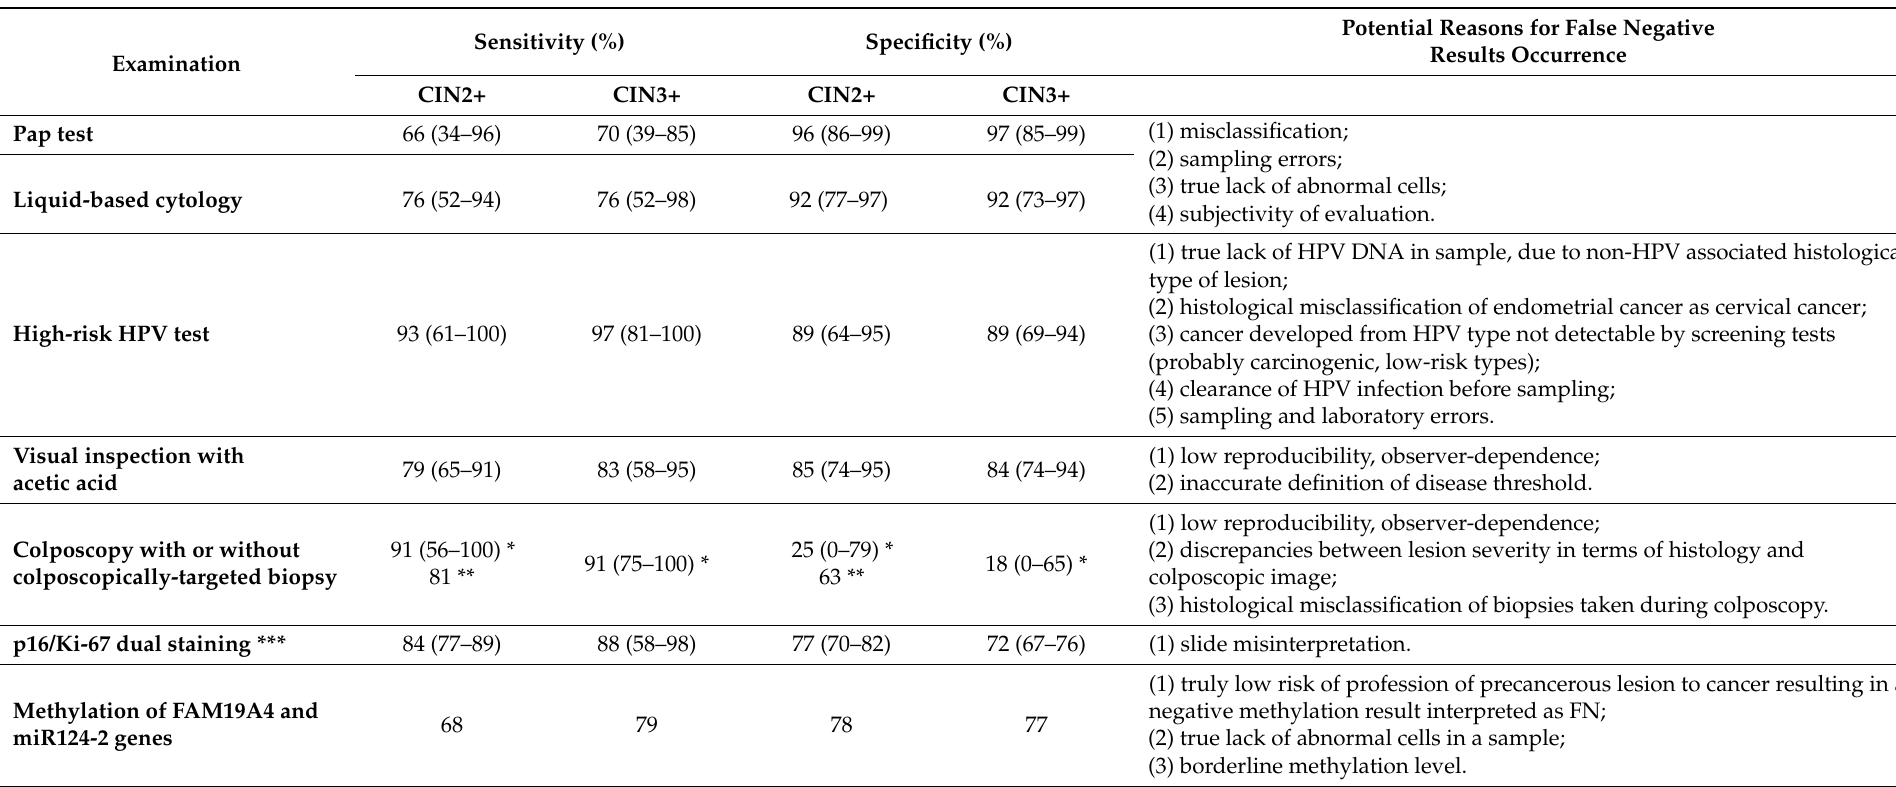
Table 1. The basic parameters of screening tests and triage methods, with potential reasons of false negative results occurrence. Sensitivity and specificity data were retrieved from comprehensive meta-analyses. Pooled rates were reported with range of parameter analyzed in brackets. For dual staining, 95% CI from meta-analyses were given in brackets. Cytology parameters were reported for atypical squamous cell of undetermined significance benchmark; * for punch biopsies taken in CIN1+ women; ** considering studies with excisional treatment following punch biopsies only; *** for women with low-grade cytological abnormalities (atypical squamous cells of undetermined significance, low-grade squamous intraepithelial